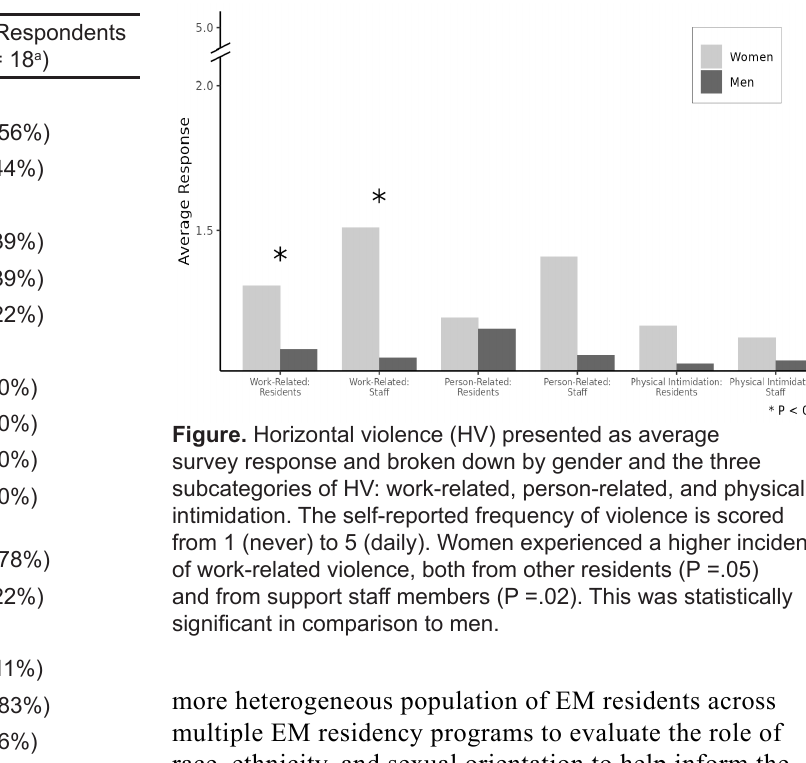
Table. Demographics of residents who participated in survey on frequency of horizontal violence.